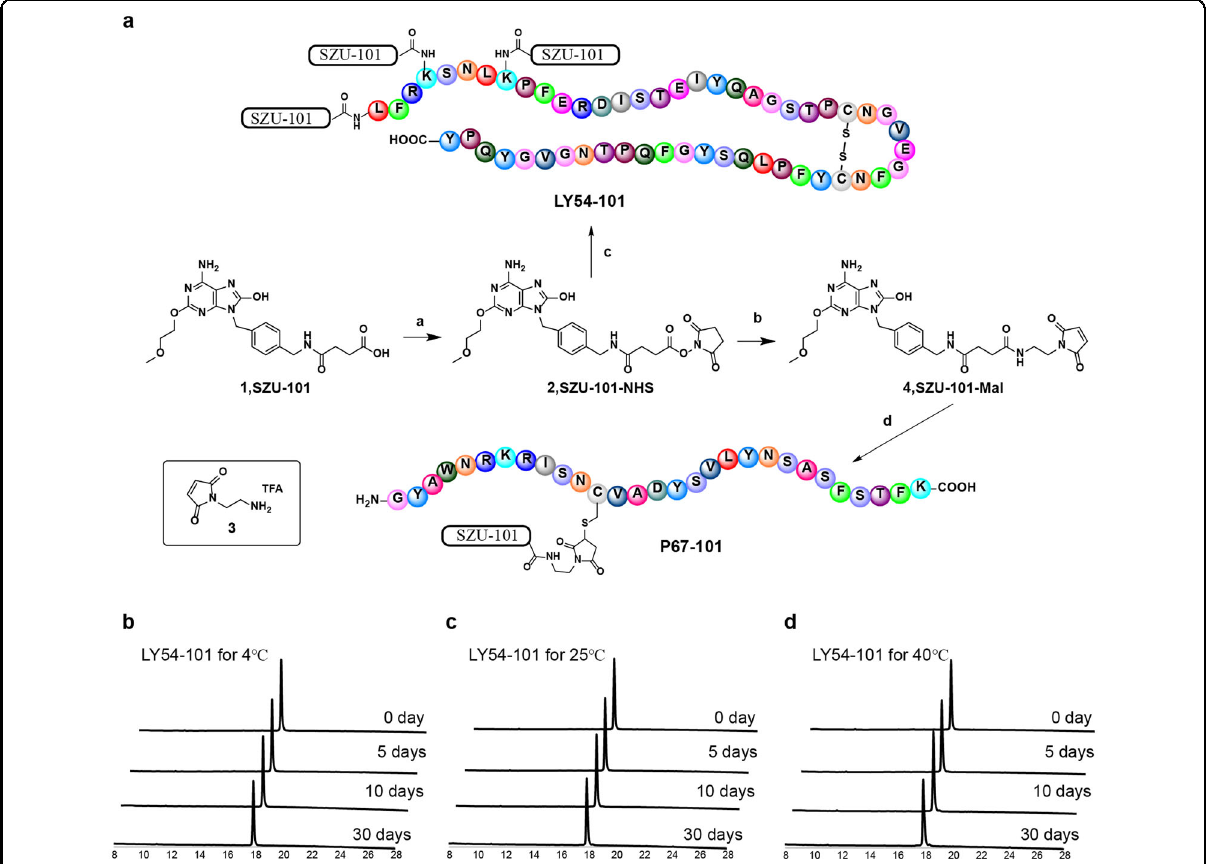
Fig. 2 Full chemical synthesis and thermal stability analysis of self-adjuvanting peptides. a Synthesis of SZU-101 derivatives and SZU-101- peptide conjugations. Reaction conditions: a, EDCI/NHS, DMSO, 15 °C, overnight; b, 3, EDCI/NHS, DMSO, 15 °C, overnight; c, LY54, NaHCO 3 , DMF/H 2 O, room temperature (RT), 2 h; d, P67, NaHCO 3 , DMF/H 2 O, RT, 1 h. b – d HPLC pro fi le of stability analysis of LY54 – 101 for 5 days, 10 days and, 30 days at 4 °C ( b ), 25 °C ( c ), and 40 °C ( d ). The horizontal axis represents the retention time (min), and the vertical axis represents the absorbance